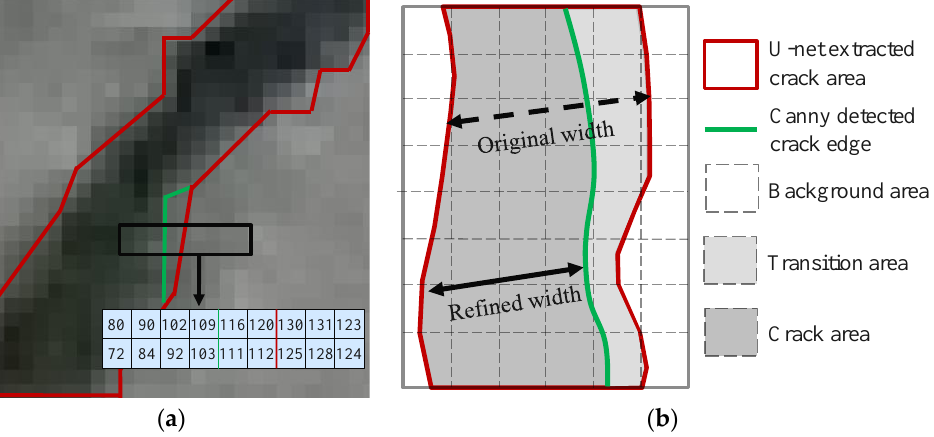
Figure 9. The comparison between U-net extracted crack area and Canny edge detection: ( a ) example of crack refining process, where the gray values are the transition area; ( b ) influence of refinement on crack width measurement.